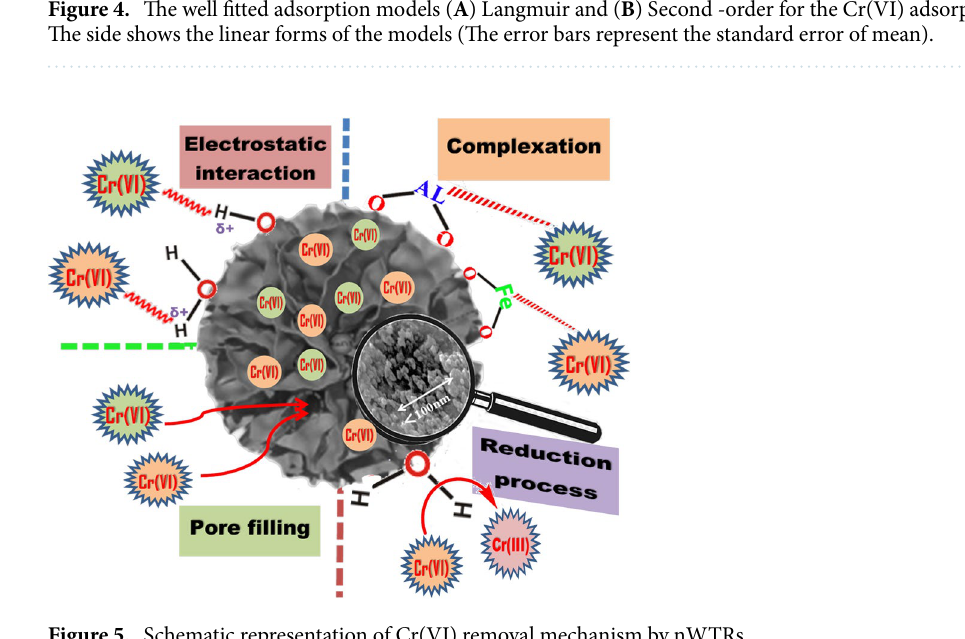
Figure 5. Schematic representation of Cr(VI) removal mechanism by